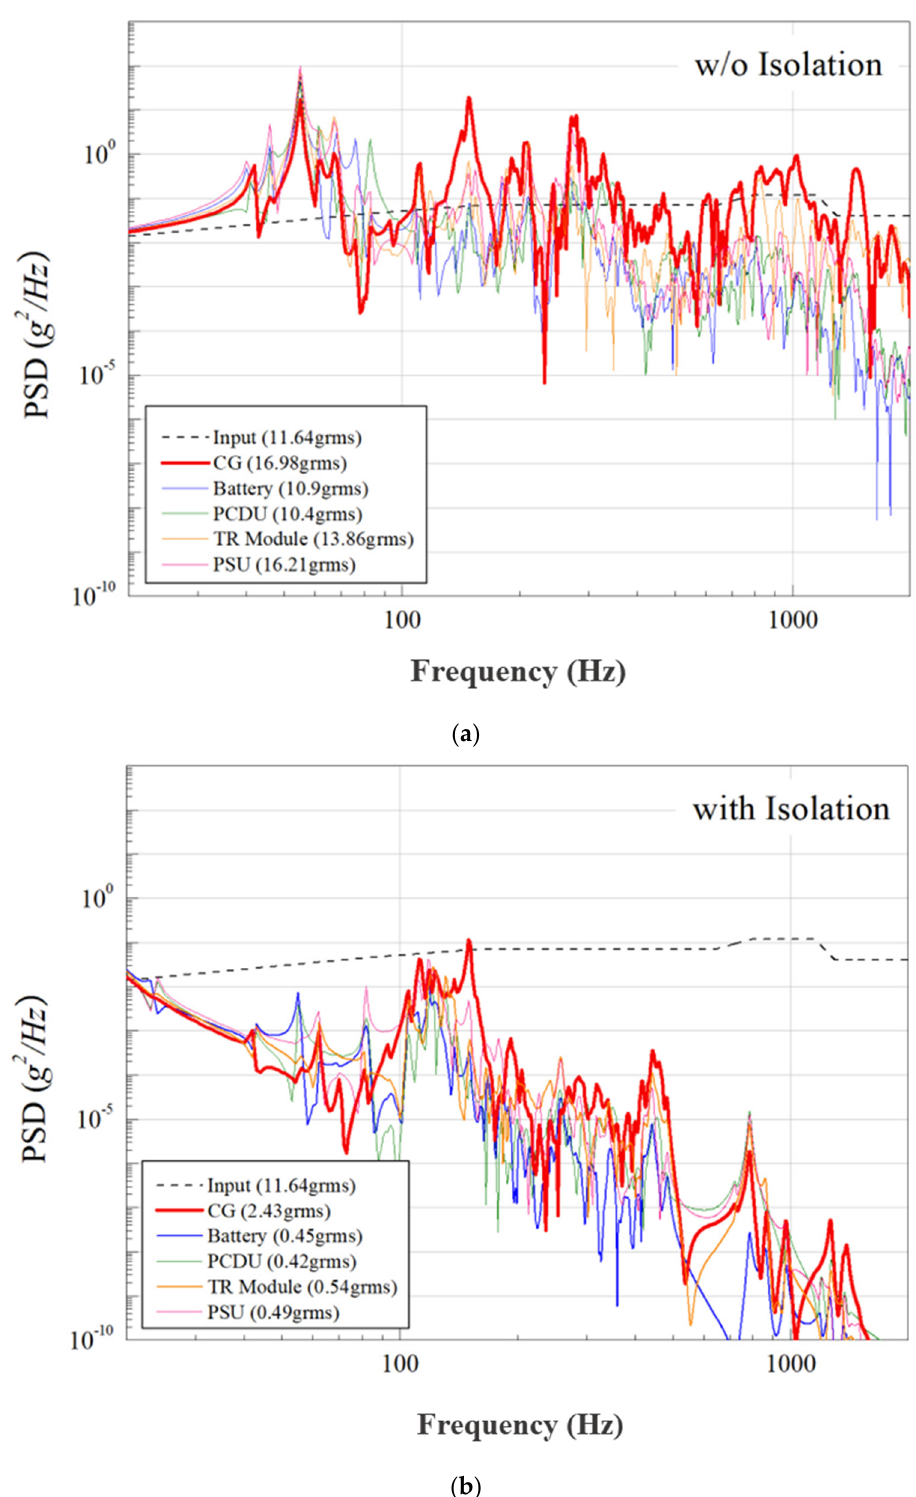
Figure 17. Random vibration analysis responses of the S-STEP system with respect to both with and without the whole spacecraft vibration isolation of the VFOD [( a ): w/o isolation, ( b ): with isolation].